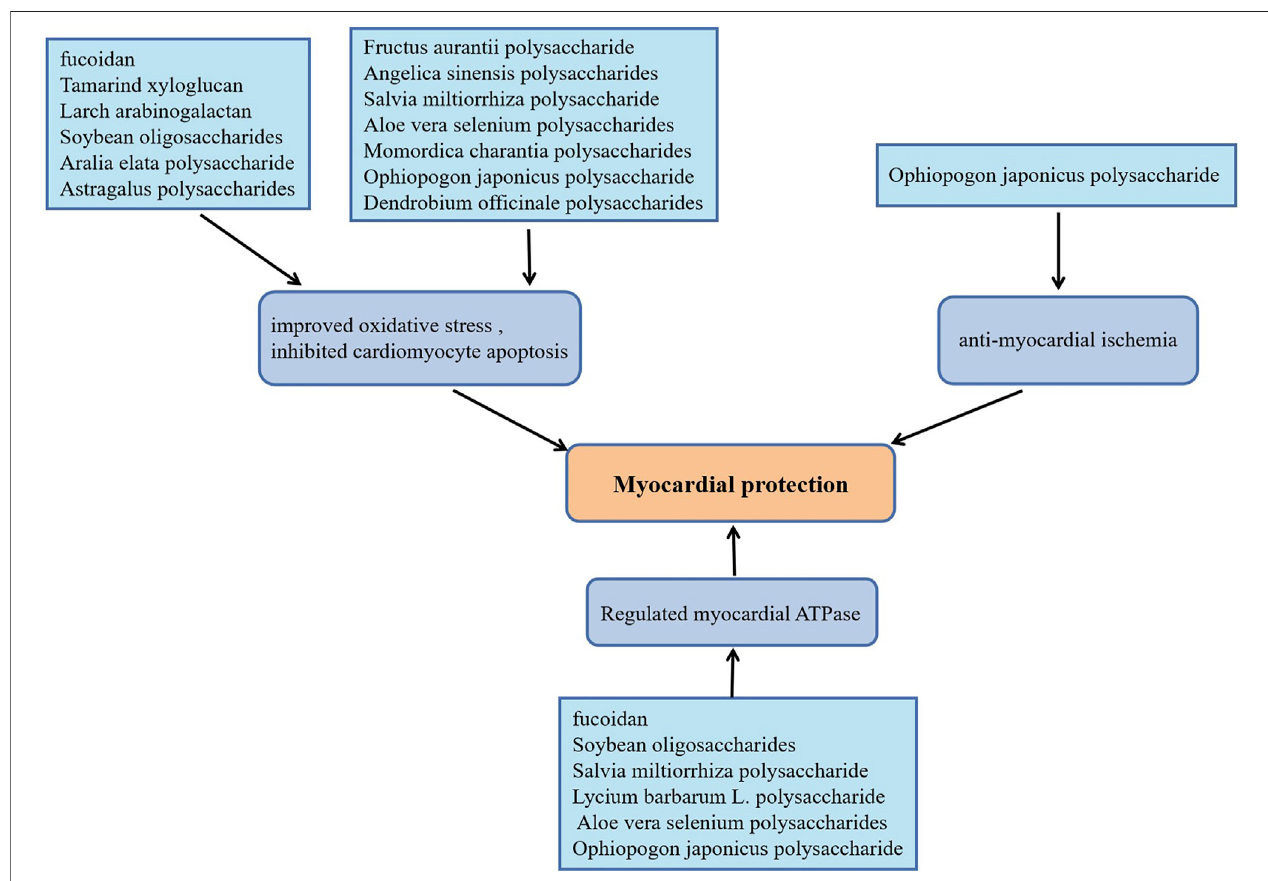
FIGURE 3 | Plant polysaccharides with myocardial protective